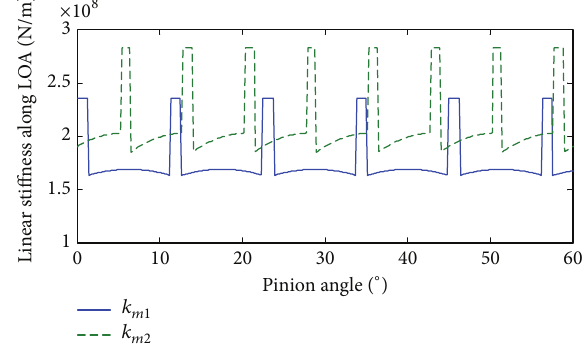
Figure 5: Mesh stiffness along the line-of-action (LOA) versus pinion angle for first- and second-stage gear